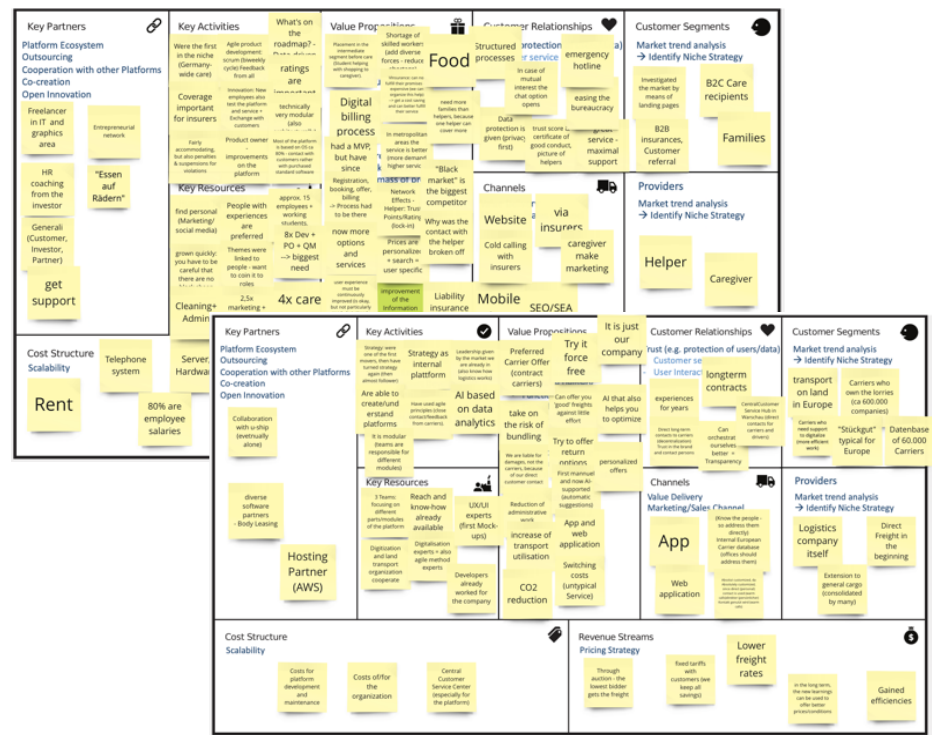
Figure 2. Final PS-BMCs, results of both